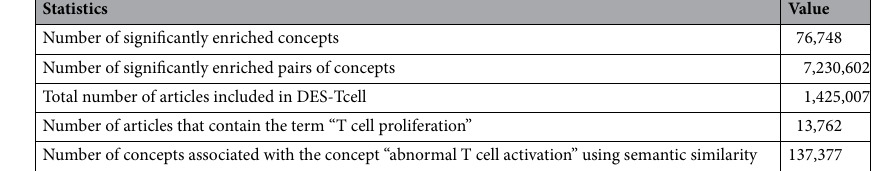
Table 2. Statistics of the DES-Tcell